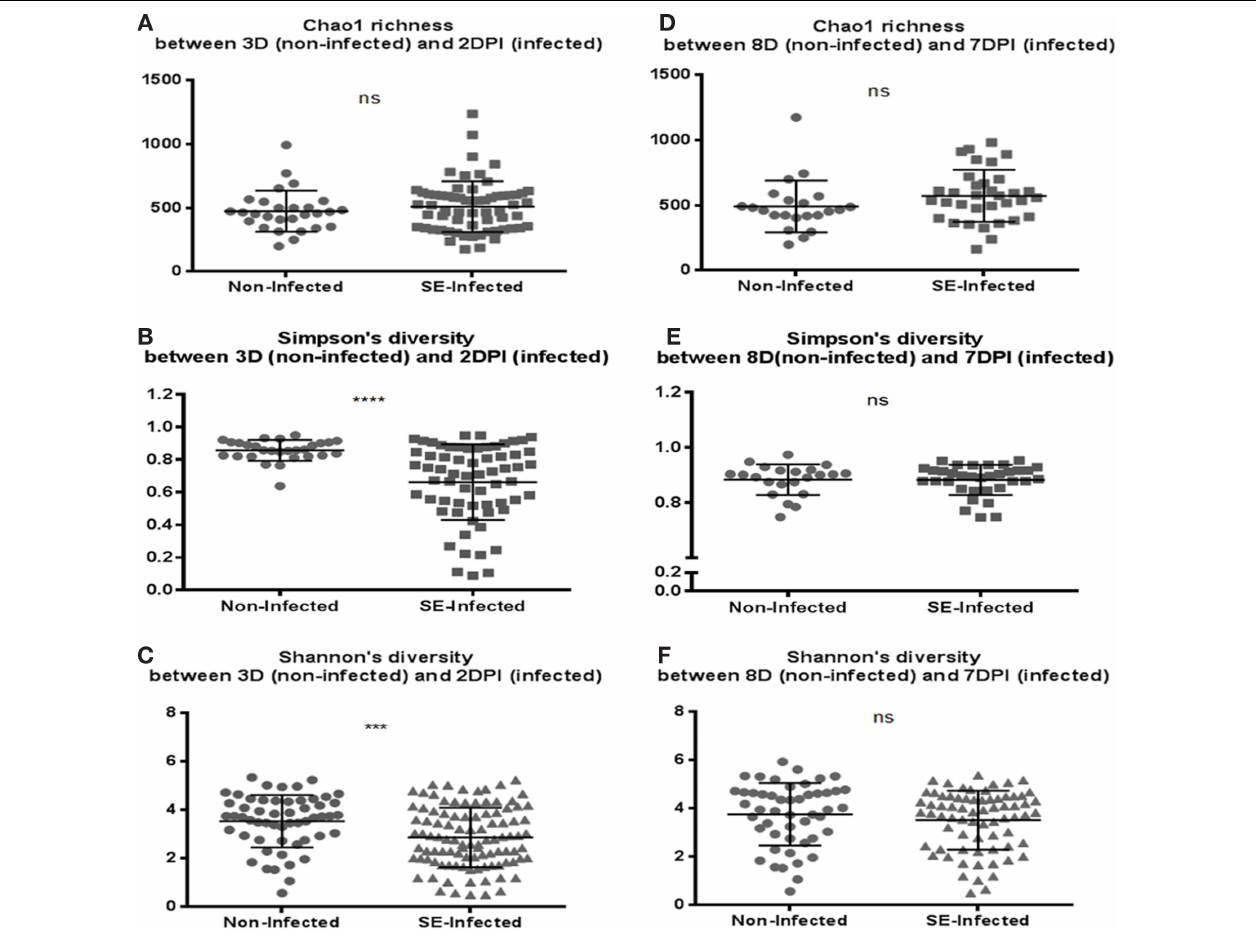
FIGURE 8 | Comparison of the diversity indices between the non-infected chicks and S. Enteritidis-infected chicks at 2 and 7DPI: (A,D) Chao1 richness estimate, (B,E) Simpson’s diversity, and (C,F) Shannon’s diversity . At 2DPI, there was significant reduction in microbial diversity of the S. Enteritidis-infected chicks compared to non-infected chicks for measurement of both Simpson and Shannon’s diversity indices. Diversity metrics were evaluated using Mann–Whitney U test. *** p value < 0.001, **** p value < 0.0001, and ns =